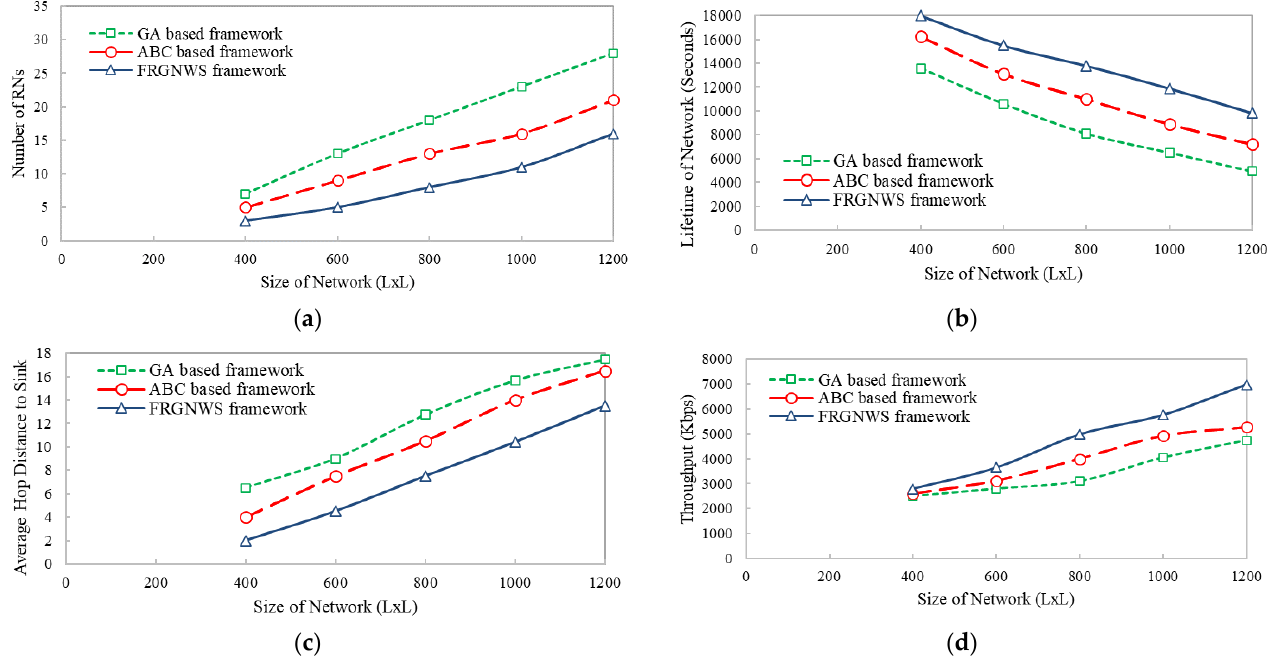
Figure 6. The outcomes of the set of simulation experiments conducted with variations in the network size: ( a ) number of RNs with variations in the network size; ( b ) lifetime of the network with variations in the network size; ( c ) average hop distance to the sink with variations in the network size; and ( d ) throughput with variations in the network size. Tables 7 – 10 are given below.